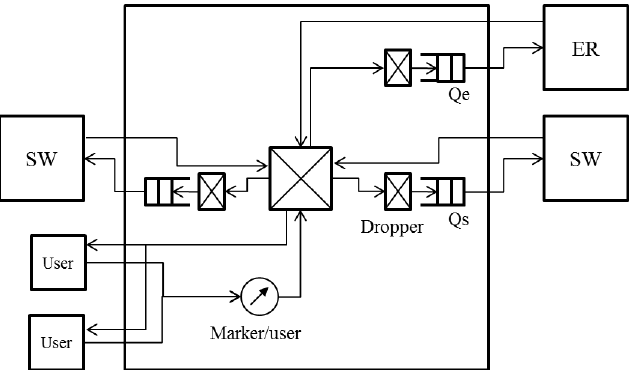
Figure 4. Node architecture for employing the proposed NRN + 1CM in a ring aggregation network with multiple